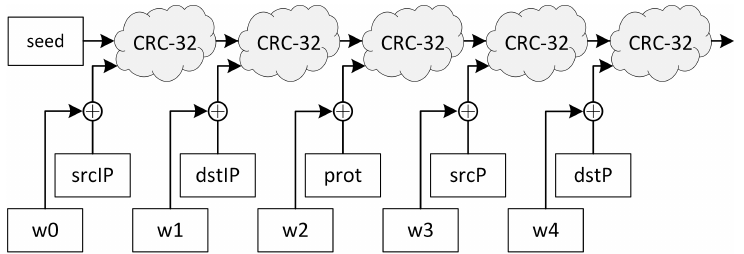
Figure 3. Illustration of modified Vermont hashing function, based on